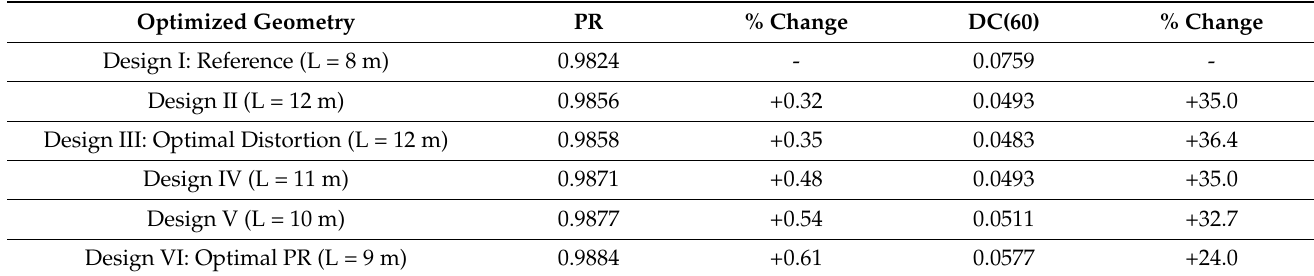
Table 4. Comparison of the Pareto optimal